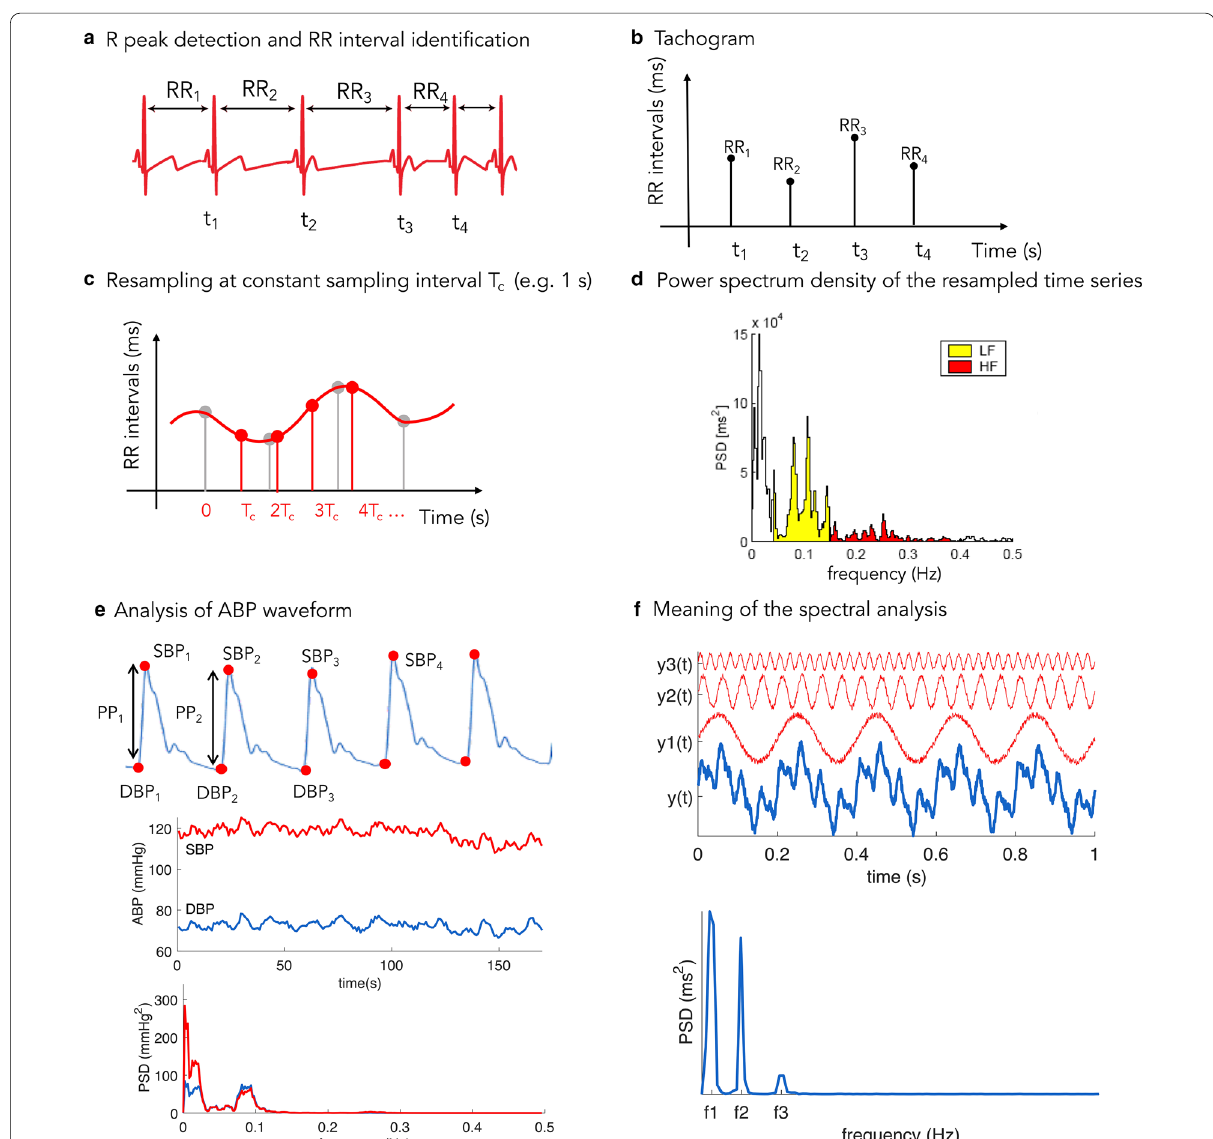
Fig. 4 Basic concepts to estimate heart rate and blood pressure variabilities. a Identification of R peaks in the ECG signal—in sinus rhythm— permits assessment of the RR interval duration for consecutive beats. b The tachogram displays RR intervals for each beat; this time series analysis permits a first visual inspection of the variability in RR interval duration, computed as the mean RR interval and its standard deviation. c Before the spectral analysis, the time series needs to be resampled at evenly spaced time intervals ( T c sampling interval which corresponds to f c 1/ T c = = sampling frequency). d Power spectrum density (PSD) computation and spectral analysis: as the parasympathetic nervous system (PNS) acts at higher frequencies than the sympathetic nervous system (SNS), the region associated with high frequency (HF, 0.15–0.4 Hz) estimates the PNS contribution to RR interval modulation, whereas the low frequency (LF, 0.04–0.15 Hz) represents mainly the SNS contribution; LF and HF indexes represent the PSD areas in those bands. e Similar to HRV, beat-to-beat series of systolic (SBP) and diastolic (DBP) blood pressure values lead first to the time domain analysis and, after resampling, to PSD computation and spectral analysis (NB: in case of blood pressure, HF variations are not related to the PNS, but mainly to the respiratory activity). The simplest way to assess the baroreflex sensitivity consists of calculating the ratio between LF components of both SBP and RR series, in their respective PSD computation. f The spectral analysis permits to disentangle the individual contributions of several modulators (in this example, the signal y ( t ) is composed of three harmonics and the PSD can clearly identify those harmonics with the low-frequency signal, y 1( t ), contributing more than the other